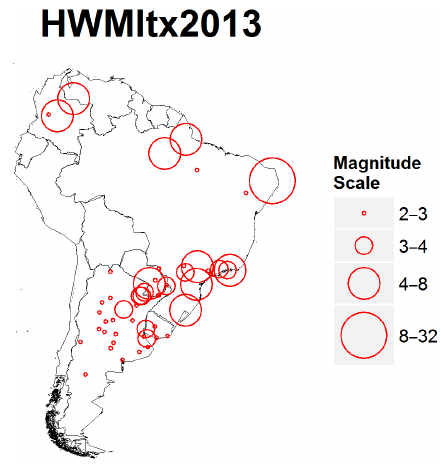
Figure 4. Heat Wave Magnitude Index of maximum tempera- ture (HWMI tx ) for